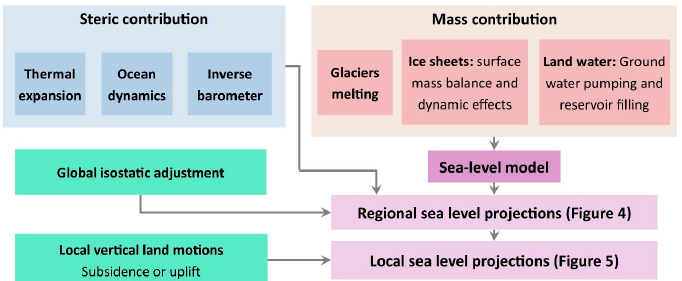
Figure 3. Methodology currently used to produce spatio-temporal sea level projections (Adapted from